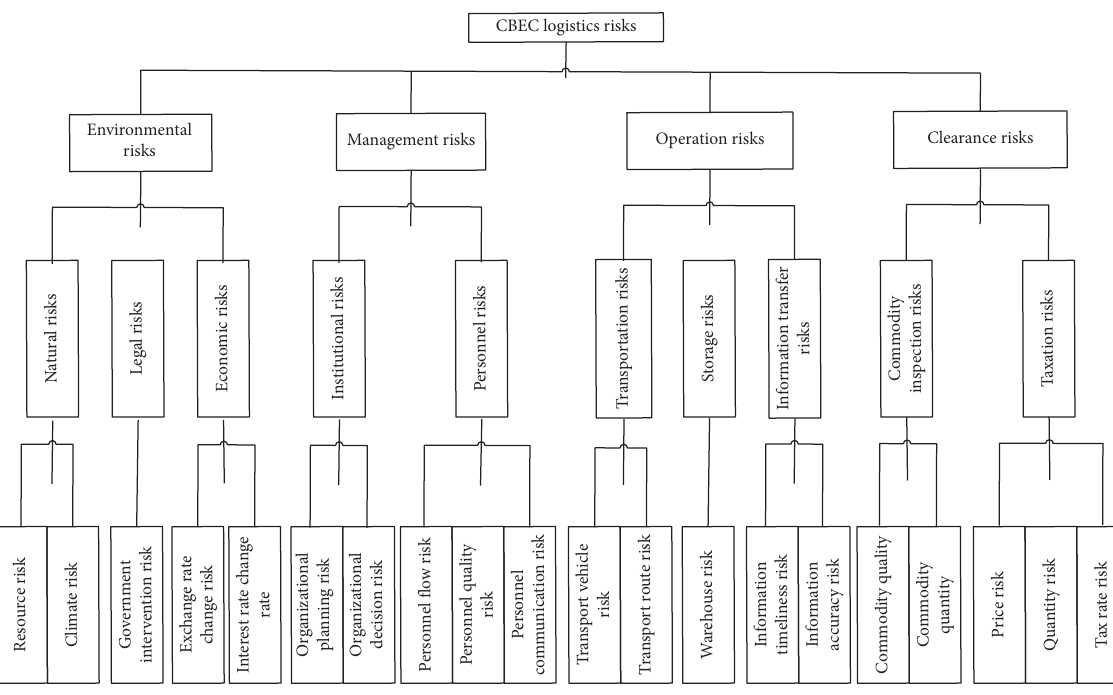
Figure 1: Risk warning